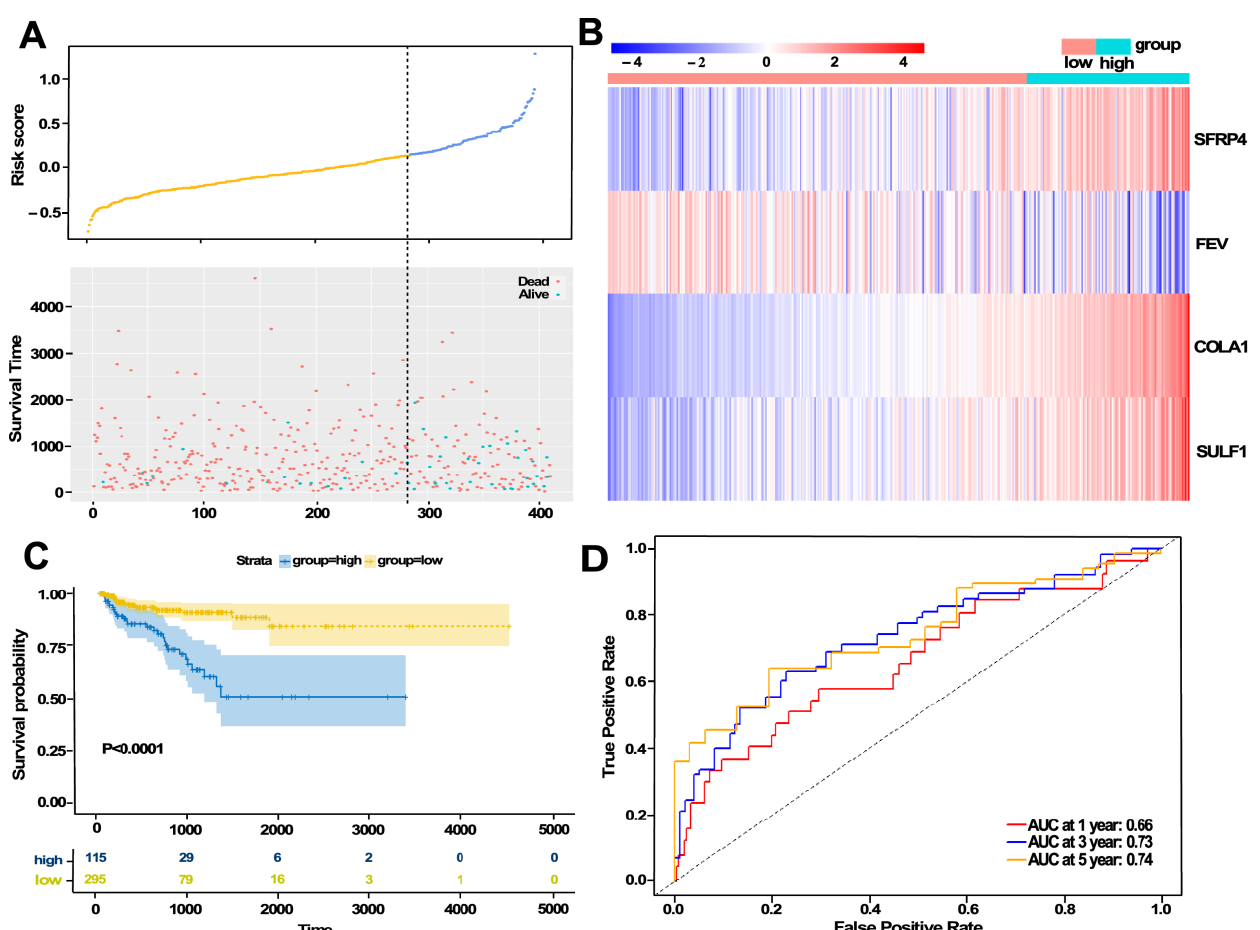
Figure 3. Construction of the four-gene signature in training cohort. ( A , B ) Distribution of risk score, BCR status, and gene expression of each case. ( C ) Kaplan – Meier curve analysis. ( D ) ROC curve analysis of the GS based four-gene signatures. Table 2. Univariate and multivariate analyses of the four-gene-based risk score and clinicopatho- logical characteristics in TCGA-PCa training set .